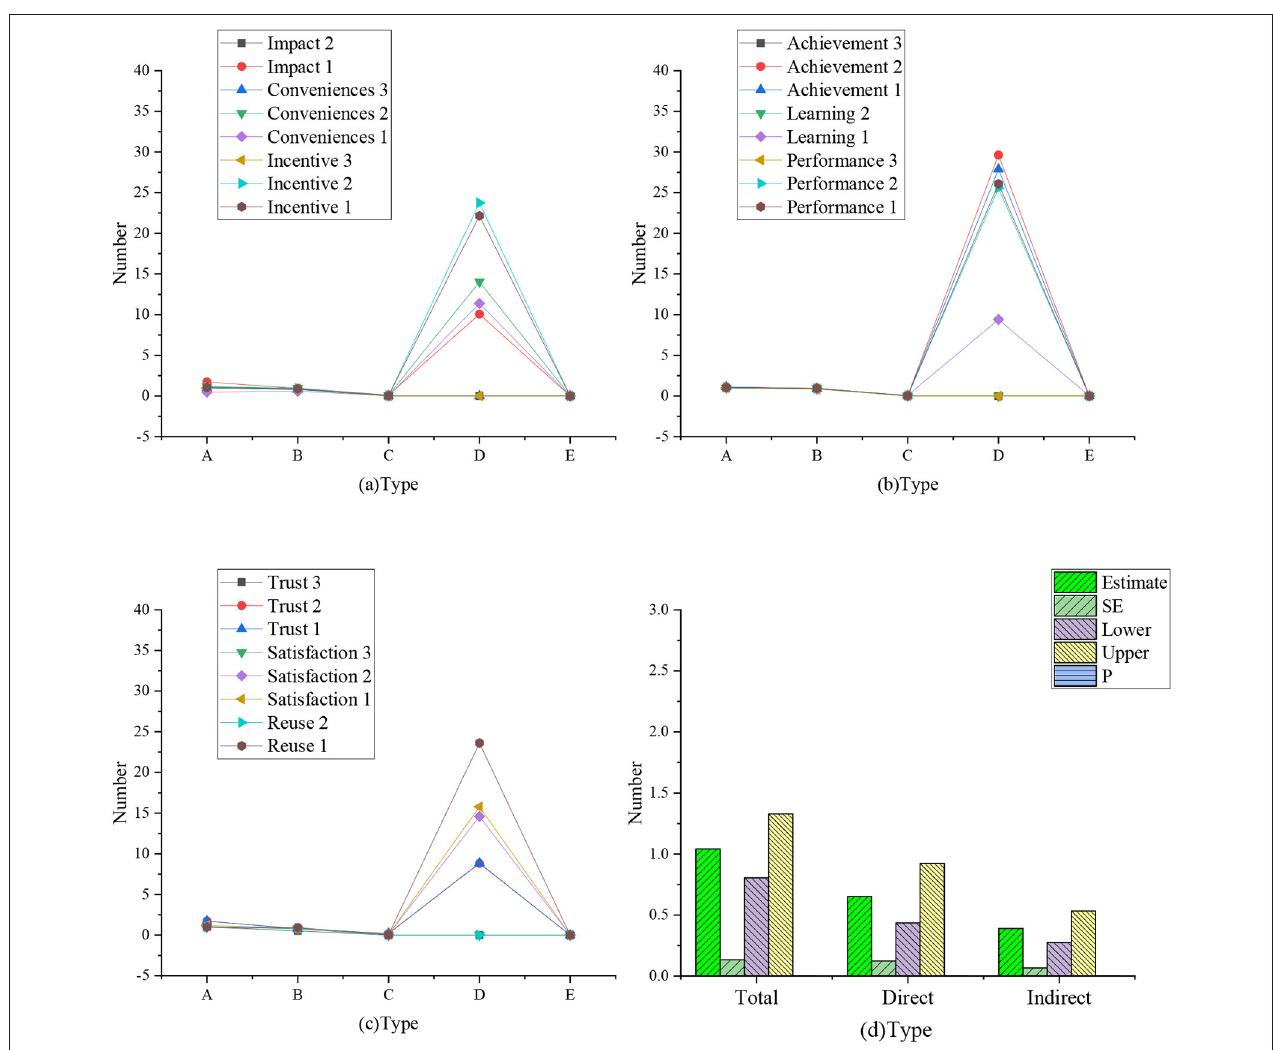
FIGURE 5 | Employee regression weight ( a : regression weight of influencing, incentive, and convenience factors; b : regression weight of learning, performance, and achievement factors; c : regression weight of trust, satisfaction, and reuse factors; d : mediation analysis conducted by employees; A: non-standard; B: standardized C: SE value; D: T -value; E: P -value).